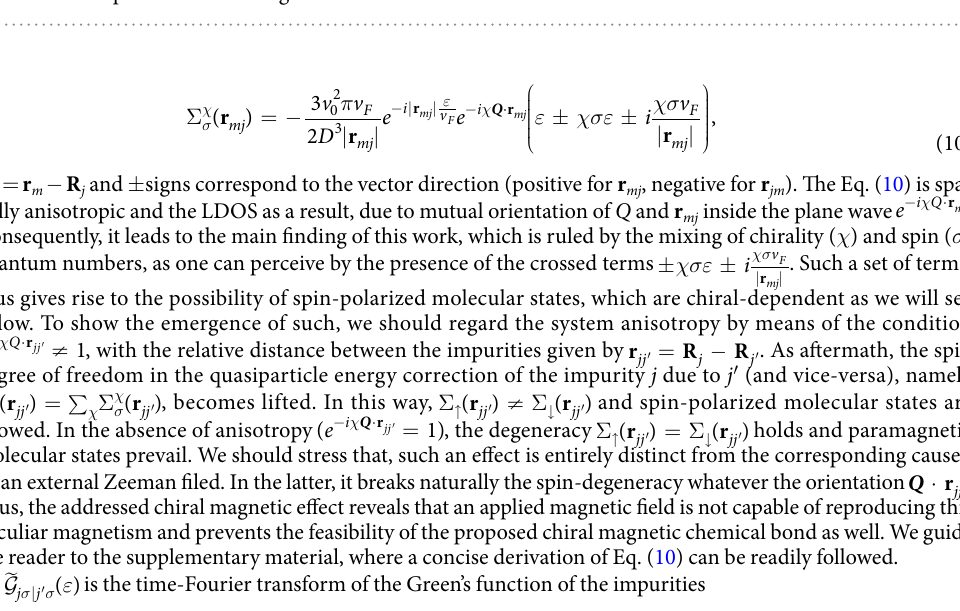
Figure 4. LDOS for the  -breaking Weyl semimetal for the case when vectors Q and r 12 are parallel (we took = . Q j 0 02 ˆ ). Panel (a) displays diagonal ( δρ ) and off-diagonal ( δρ ) contributions to the LDOS. The total LDOS jj jj is presented in the panel (b). Panel (c) shows spin-resolved density of states. The map of the total LDOS on the x y r ( , , 1) nm m = surface for the energies corresponding to the four spin-resolved molecular states is presented in the panels (d–g). Panel (h) illustrates how molecular orbitals presented in the panels (d–g) are formed from atomic orbitals presented in the Fig.